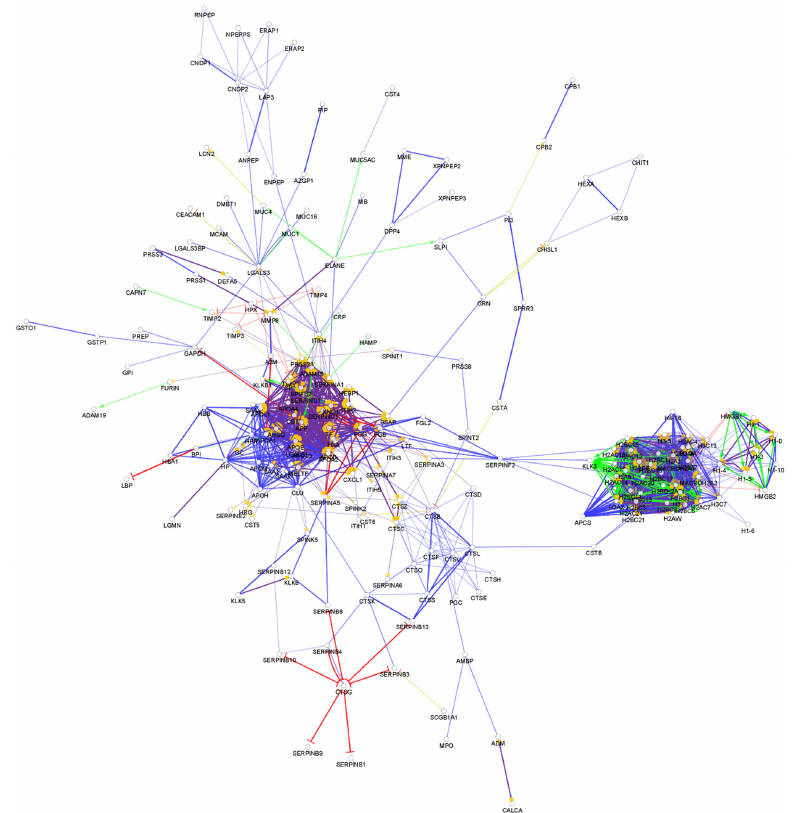
Figure 6. Partial network view of the interaction network of the chemical barrier proteins in urine. Each circle represents a protein and the lines indicate interactions. The lines with an arrow represent activation, blocking lines represent inhibition, and simple lines represent protein–protein interaction. Line color indicates the type of interaction: green color refers to activation, red color to inhibition, blue color to binding, yellow color to co-expression, and purple color to catalysis. The proteins are labeled with their gene name. The high resolution and complete network image of this network is presented in Figure S6.